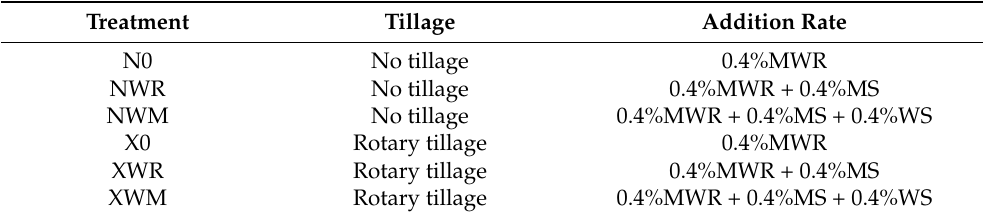
Table 1. Tillage and residue management in the laboratory incubation. Treatment Tillage Addition